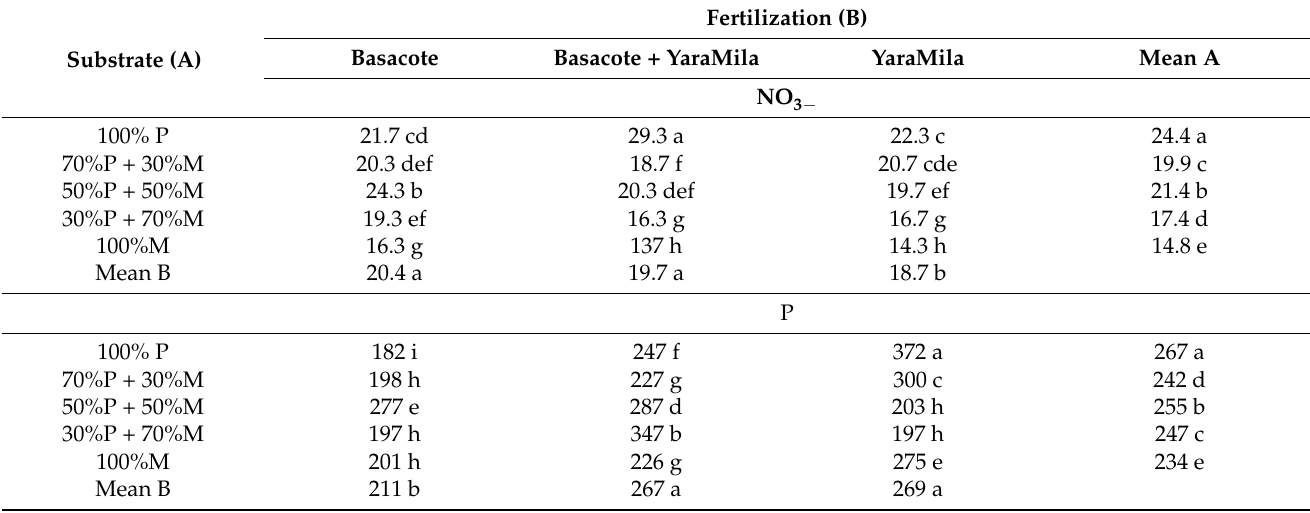
Table 10. Foliar nutrient contents (mg/g) in Sedum spectabile ‘Stardust’ grown in containers with five different